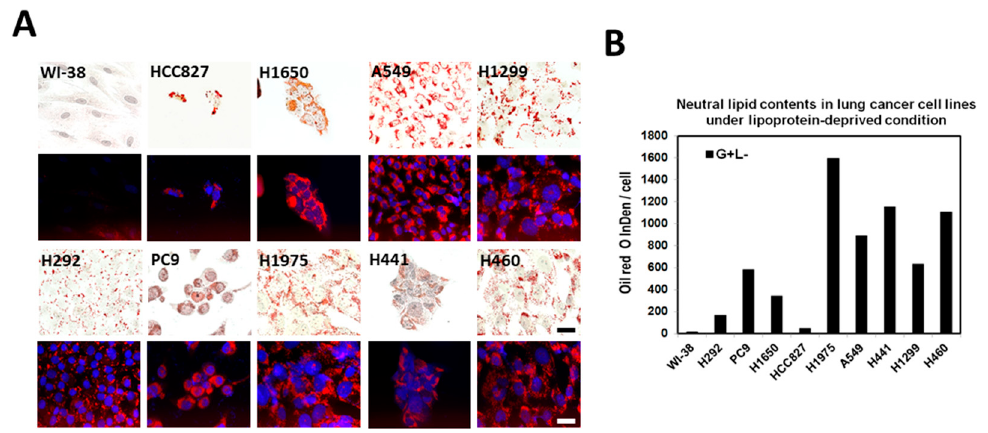
Figure 4. Lipid droplet formation induced by lipoprotein-deprived medium. Lung cancer cell lines are seeded into a lipoprotein-depleted medium. After seven days of growth, cells were fixed and stained with ORO and DAPI to stain LDs (labeled in red) and nuclei (labeled in blue), respectively. Images were captured at 400 × magnification (scale bar, 50 µ m) ( A ). The neutral lipid contents were quantitated using ImageJ as described previously ( B ).